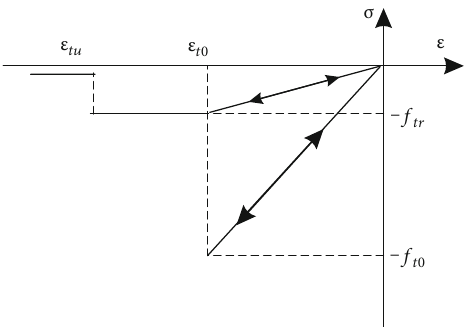
Figure 3: Constitutive relationship of elastic damage under uniaxial tension.